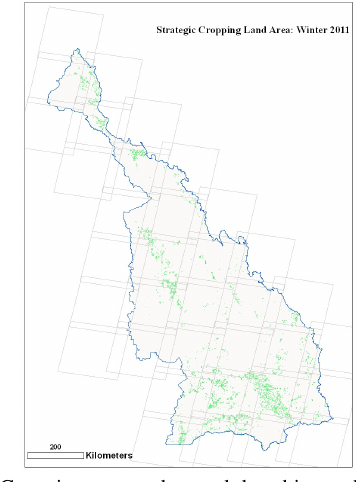
Figure 8. Cropping areas detected by this study within the Strategic Cropping Land trigger map during winter 2011, as indicated by green patches in the